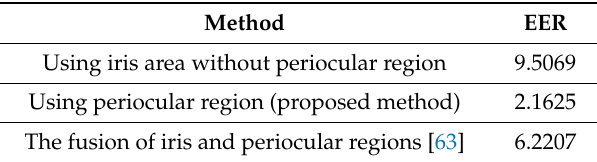
Table 11. Comparative EERs on CASIA-Iris-Distance database for measuring the effect of iris or periocular region based on [63] (unit: %).